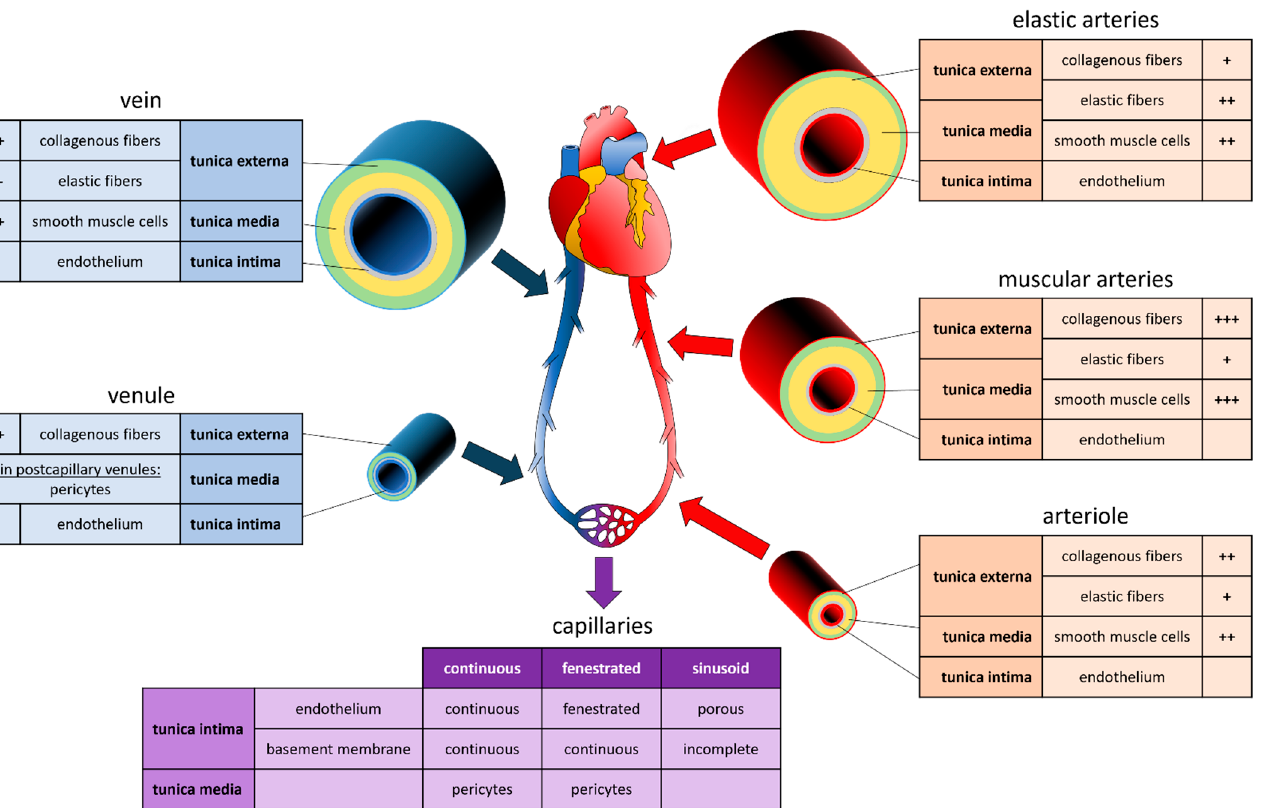
Figure 1. Composition of Vessels in the Cardiovascular System. Graphic and text inserts represent the composition of arteries (red), veins (blue) and capillaries (purple). For each section, the tunica externa (green), the tunica media (orange), and the tunica intima (grey) are indicated, as well as the proportion in collagenous fibers, elastic fibers, smooth muscle cells, and endothelium, ranging from lowest (-) to highest (+++) proportion.